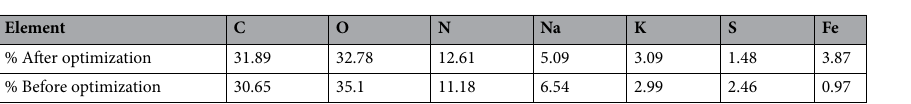
Table 7. Elemental percentage in prepared samples before and after optimization study as estimated by EDX.